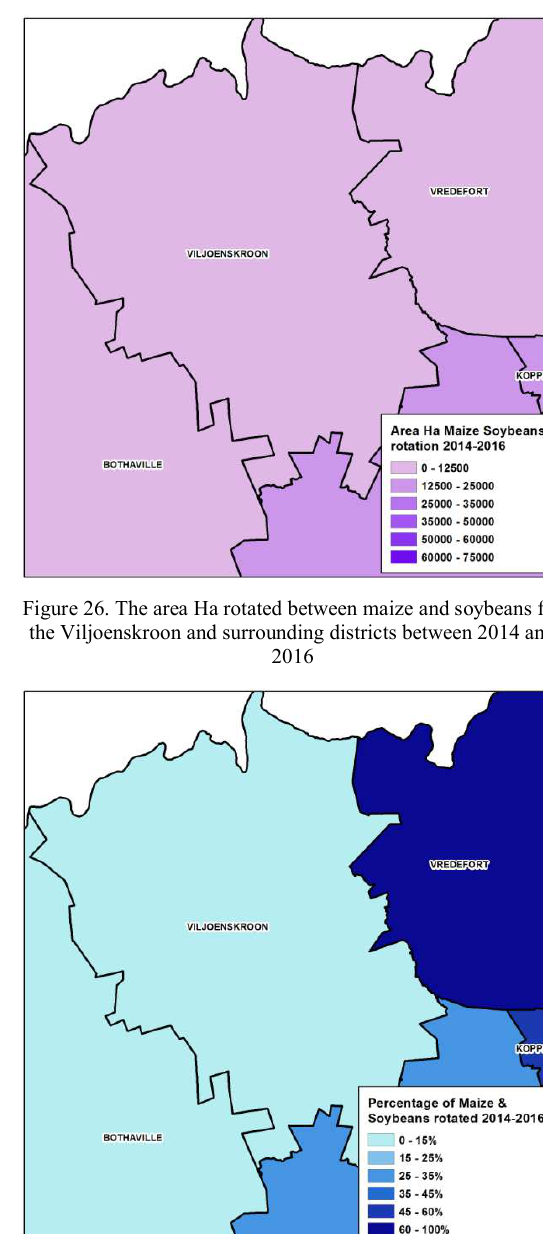
Figure 27. The percentage of area of maize and soybeans rotated for the Viljoenskroon and surrounding districts between 2014 and